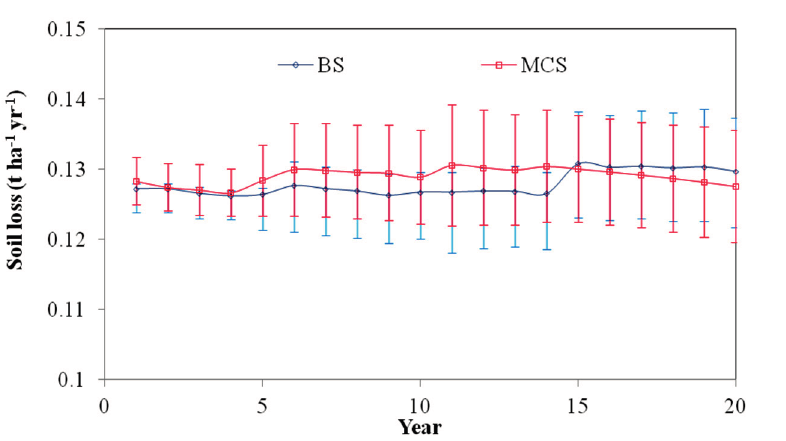
Figure 7. Simulated agricultural land-use change under the ( a ) BS and ( b ) MCS scenarios.